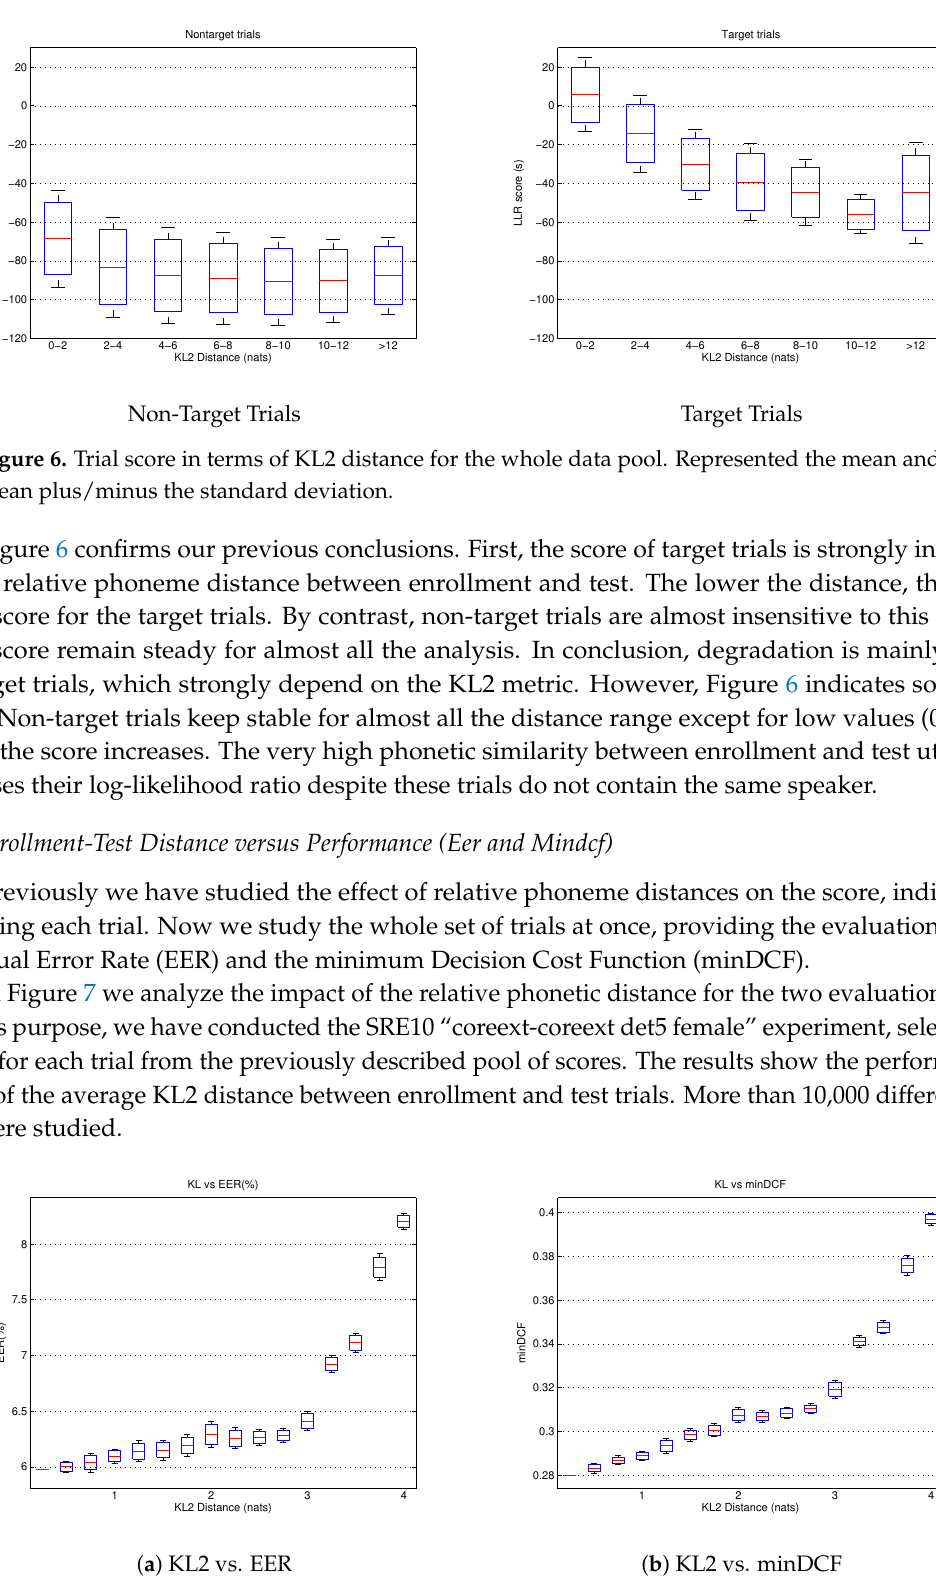
Figure 7. Evaluation metrics, EER ( a ) and minDCF ( b ) in terms of the KL2 distance. Represented the mean and mean plus/minus the standard deviation of the metric per